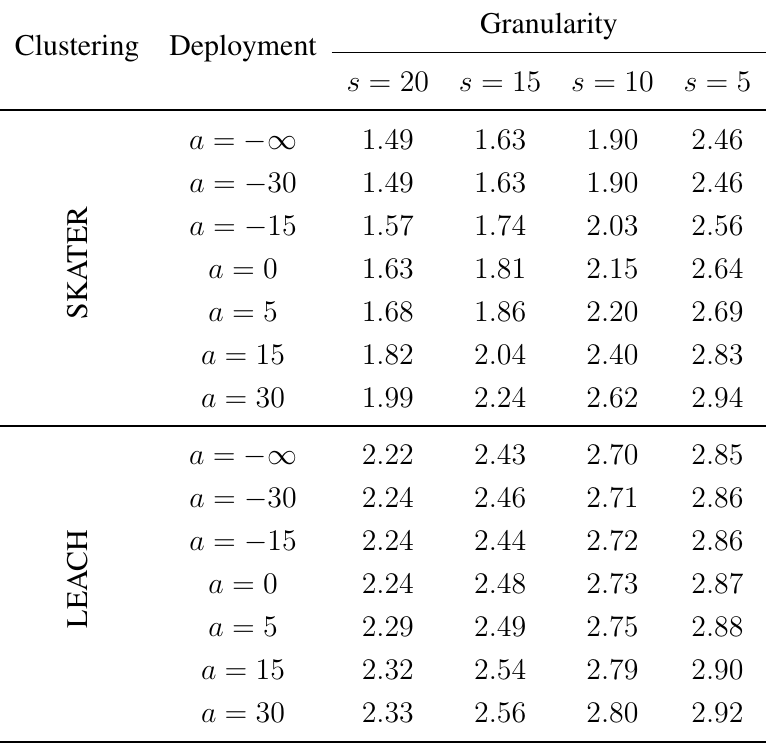
Table 2. Relative errors using reconstruction by